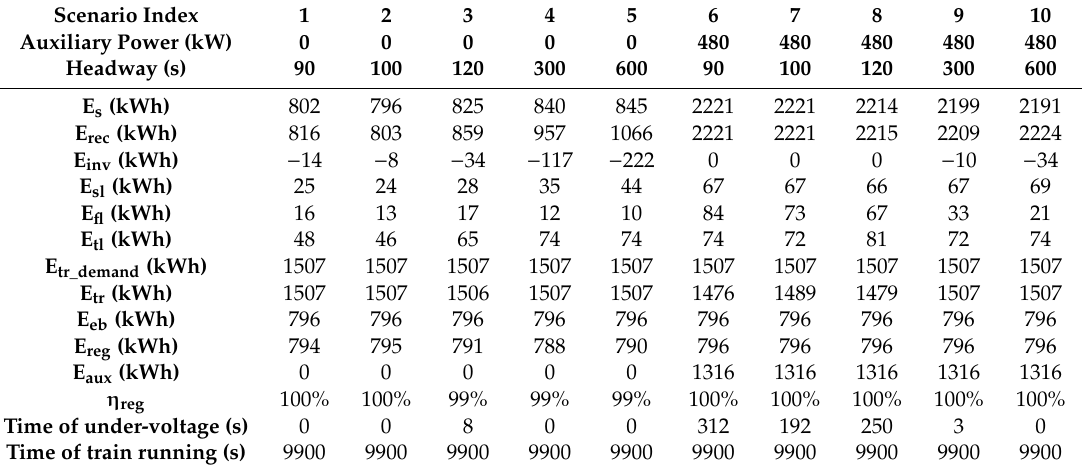
Table 4. Energy consumption of the 40 km / h case study.